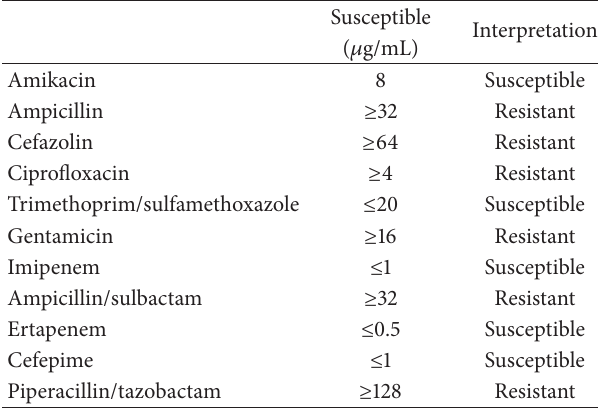
Table 1: Susceptibility profile of Escherichia coli cultured from sputum.